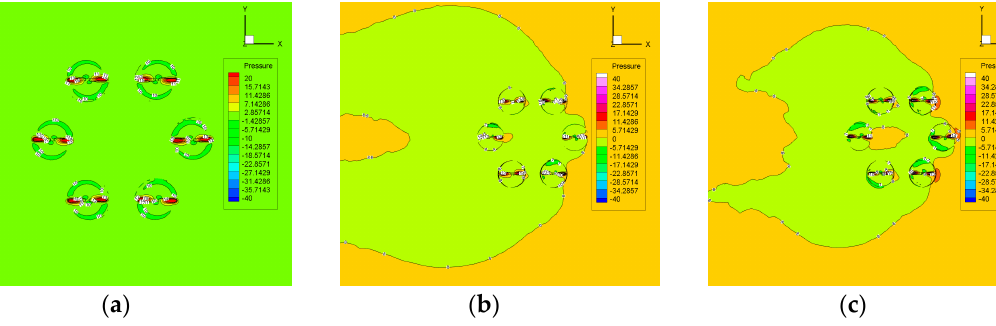
Figure 10. Pressure distribution on the center plane of the Hex-rotor UAV ( a ) 0 m/s ( b ) 2.5 m/s ( c ) 4 m/s.